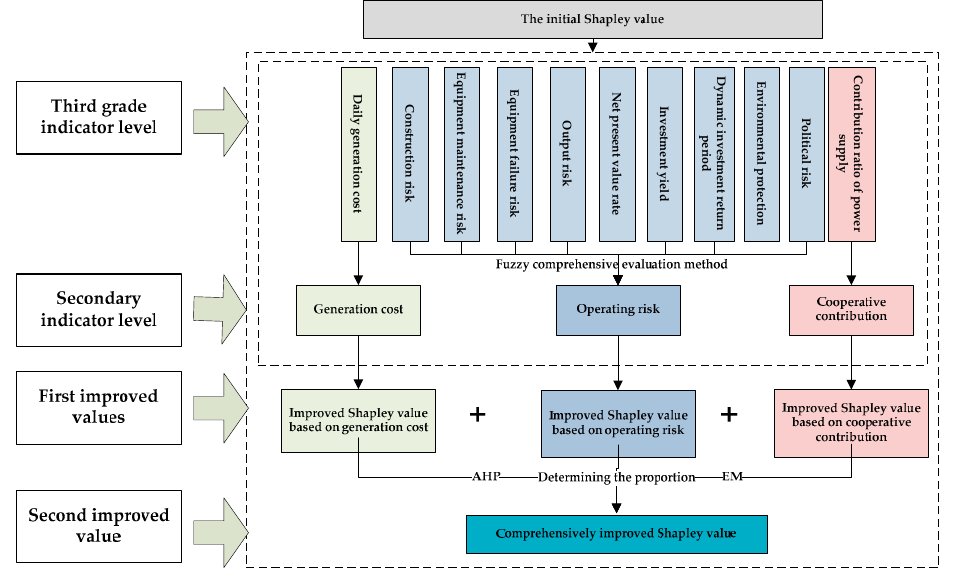
Figure 4. Basic Flow Chart of Improved Shapley Algorithm.